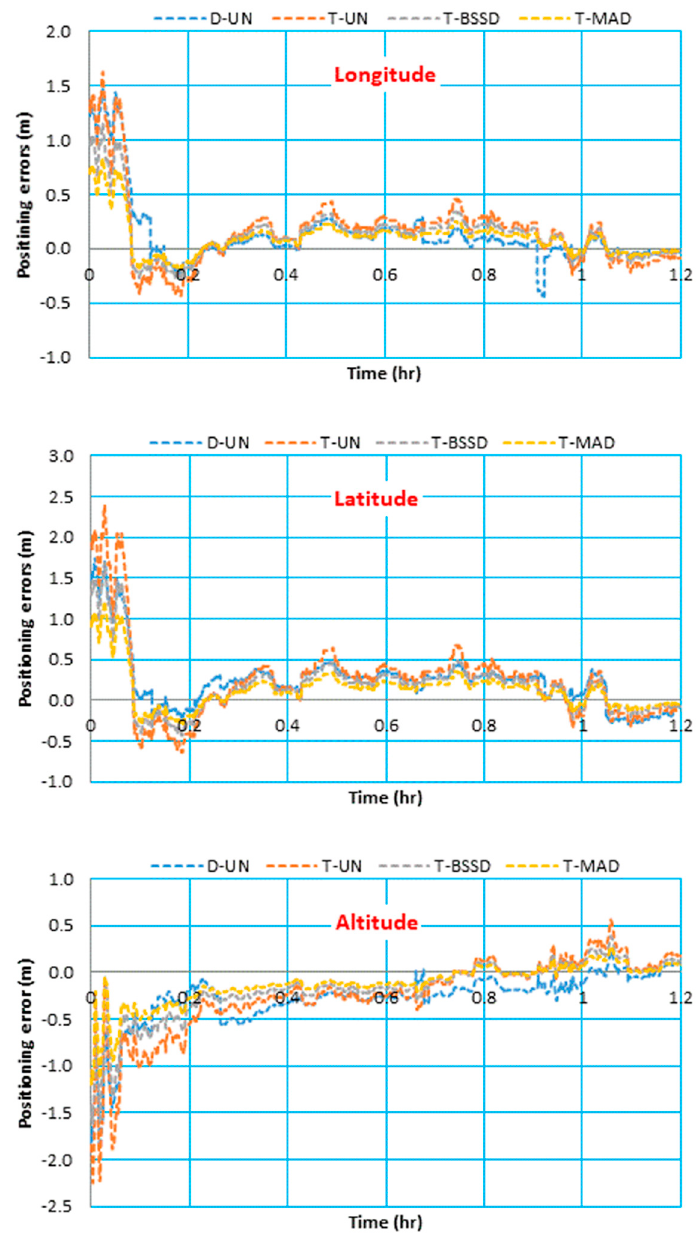
Figure 8. Positioning errors of different kinematic GPS/Galileo PPP solutions in longitude, latitude Figure 8. Vehicle and altitude.